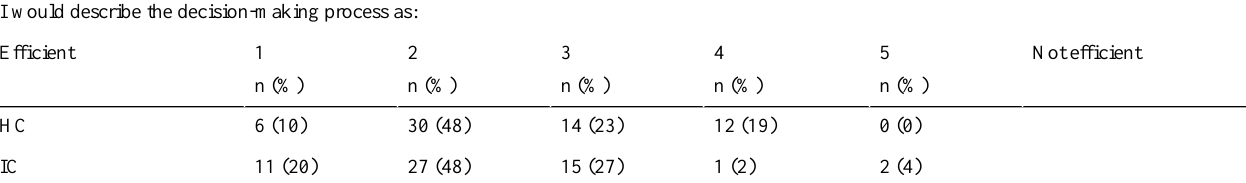
Figure 12. Percentage of arguments in the different categories of the coding